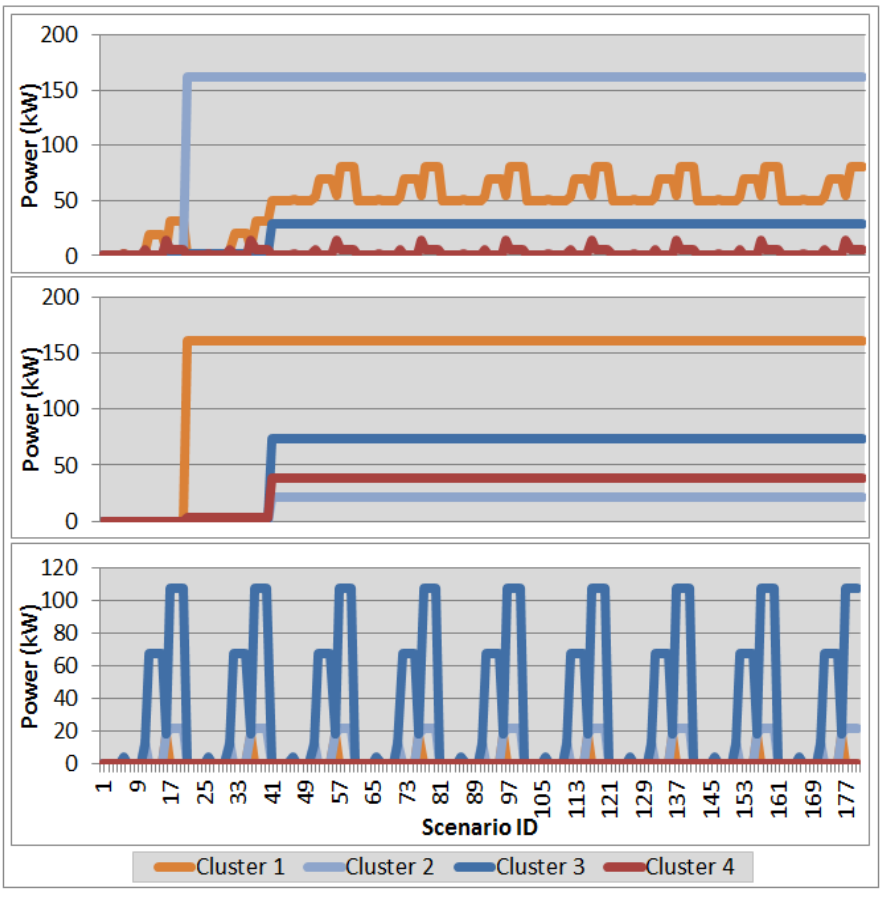
Figure 7. Cluster representative profiles.